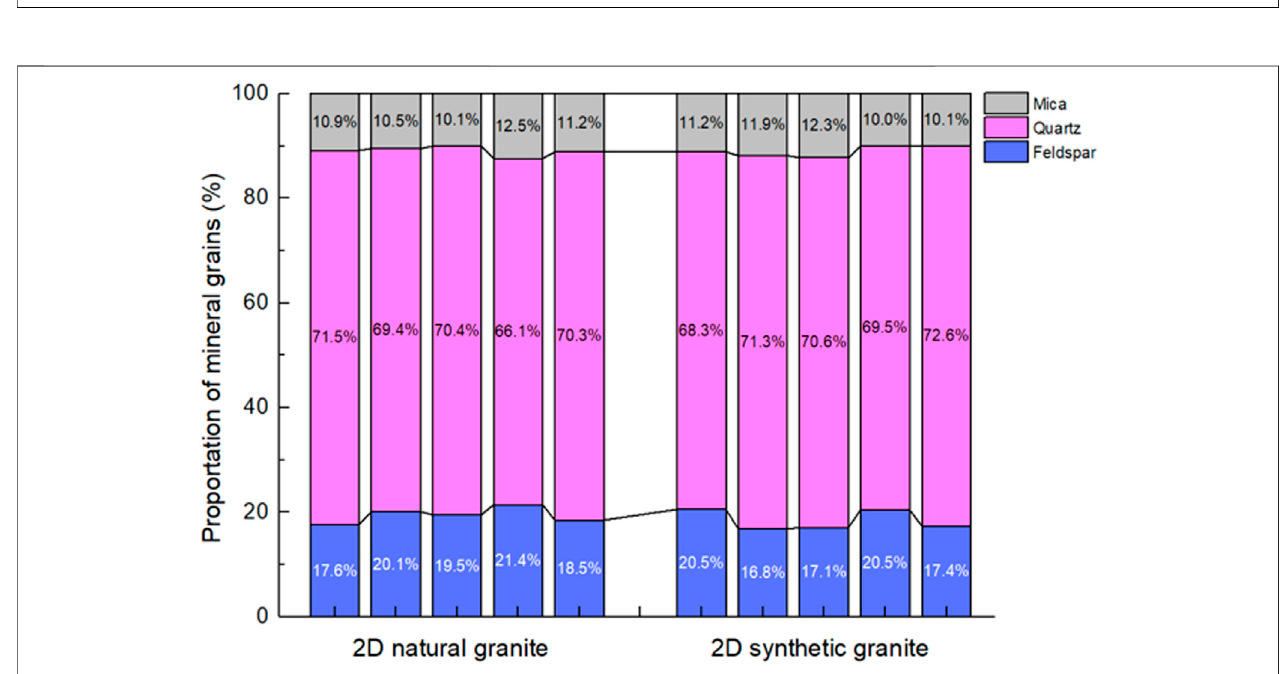
FIGURE 4 | Natural granite models and equal-size synthetic granite models.